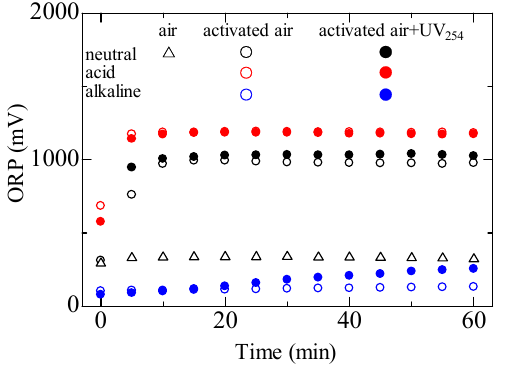
Fig. 6 Time evolution of ORP with or without UV irradiation.